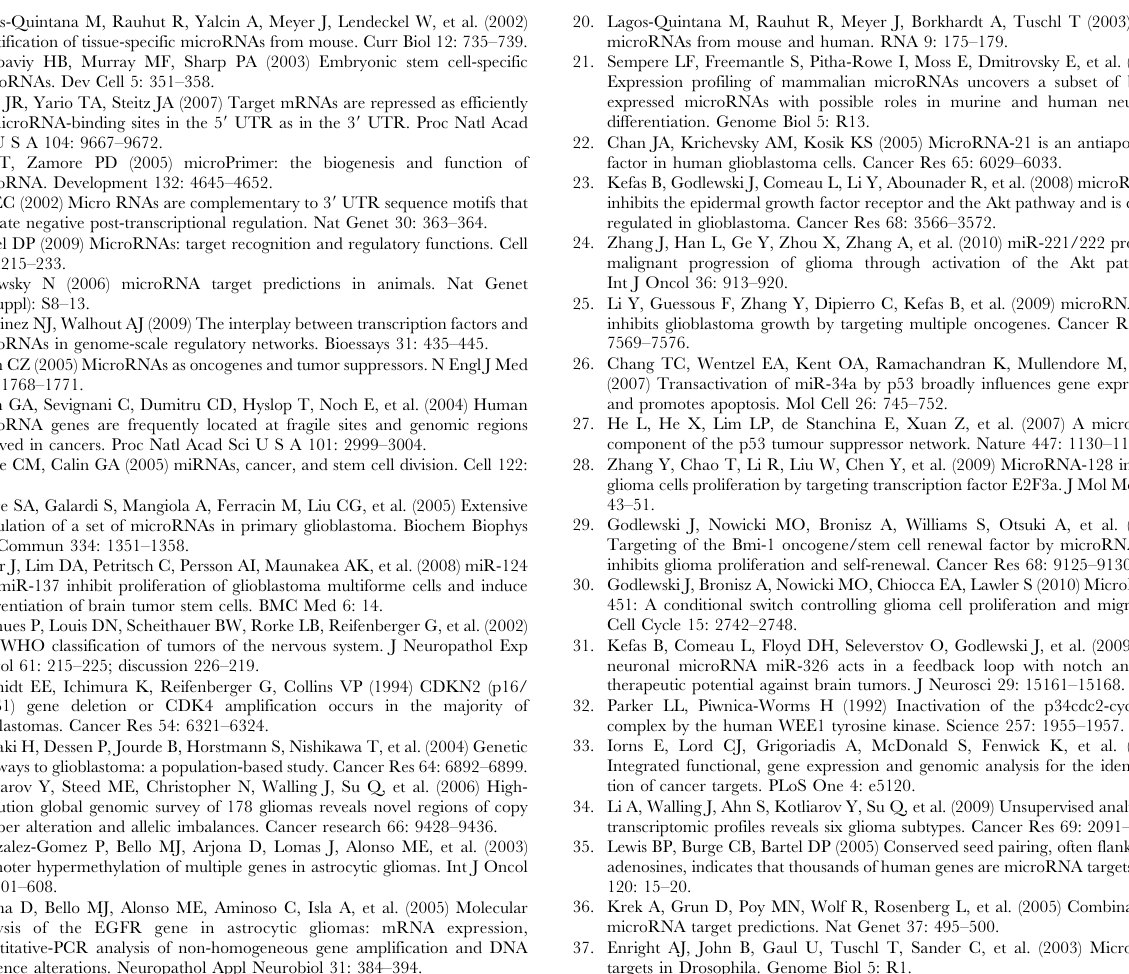
Table S2 List of 20,288 genes and their lg 2 -fold change of expression in 27 GBM and 11 non-tumor samples.